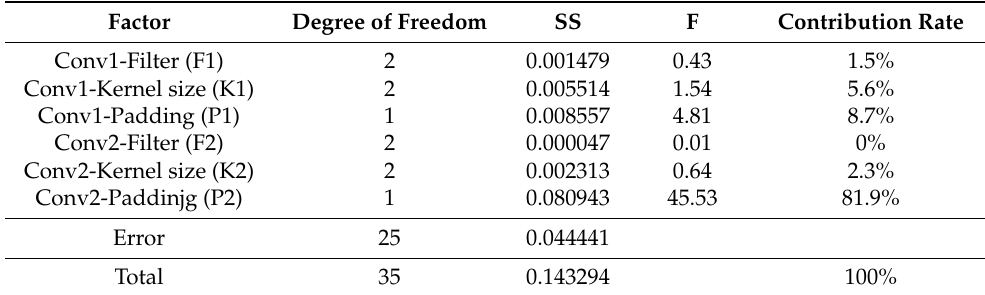
Table 8. Results of ANOVA.